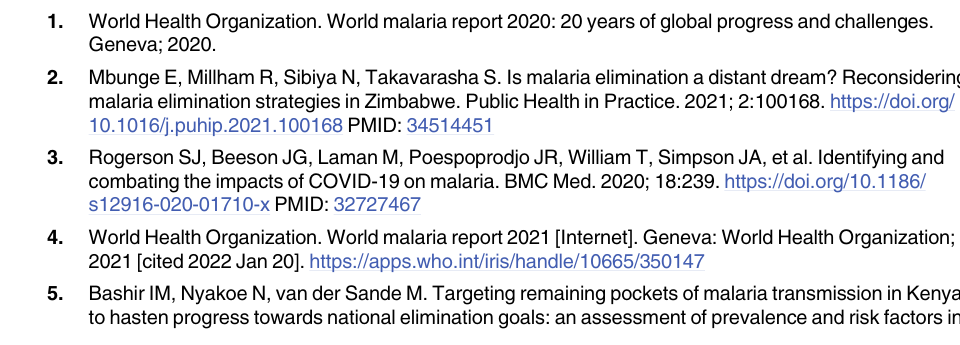
S1 Table. Tables presenting the results of logistic regression of the factors associated with knowledge, attitude, prevention, and care-seeking behaviors of the adolescent. Tables are ordered as follows: Table A Logistic regression of the determinants related to malaria knowl- edge among adolescents; Table B Logistic regression of the factors associated with attitude of the participants towards malaria; Table C Logistic regression of the factors associated with malaria prevention practice; Table D Logistic regression of factors associated with malaria care-seeking